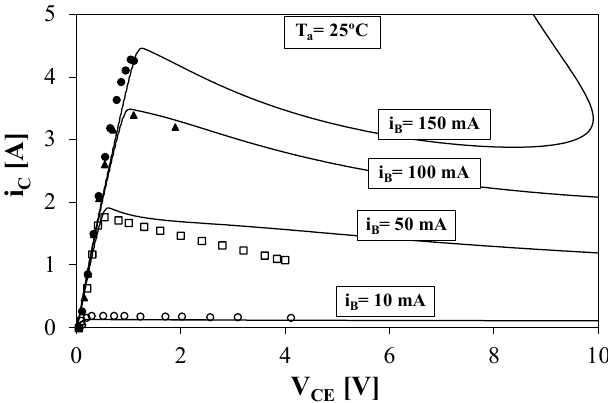
Figure 5. Non-isothermal output characteristics of the BT1206-AC transistor.